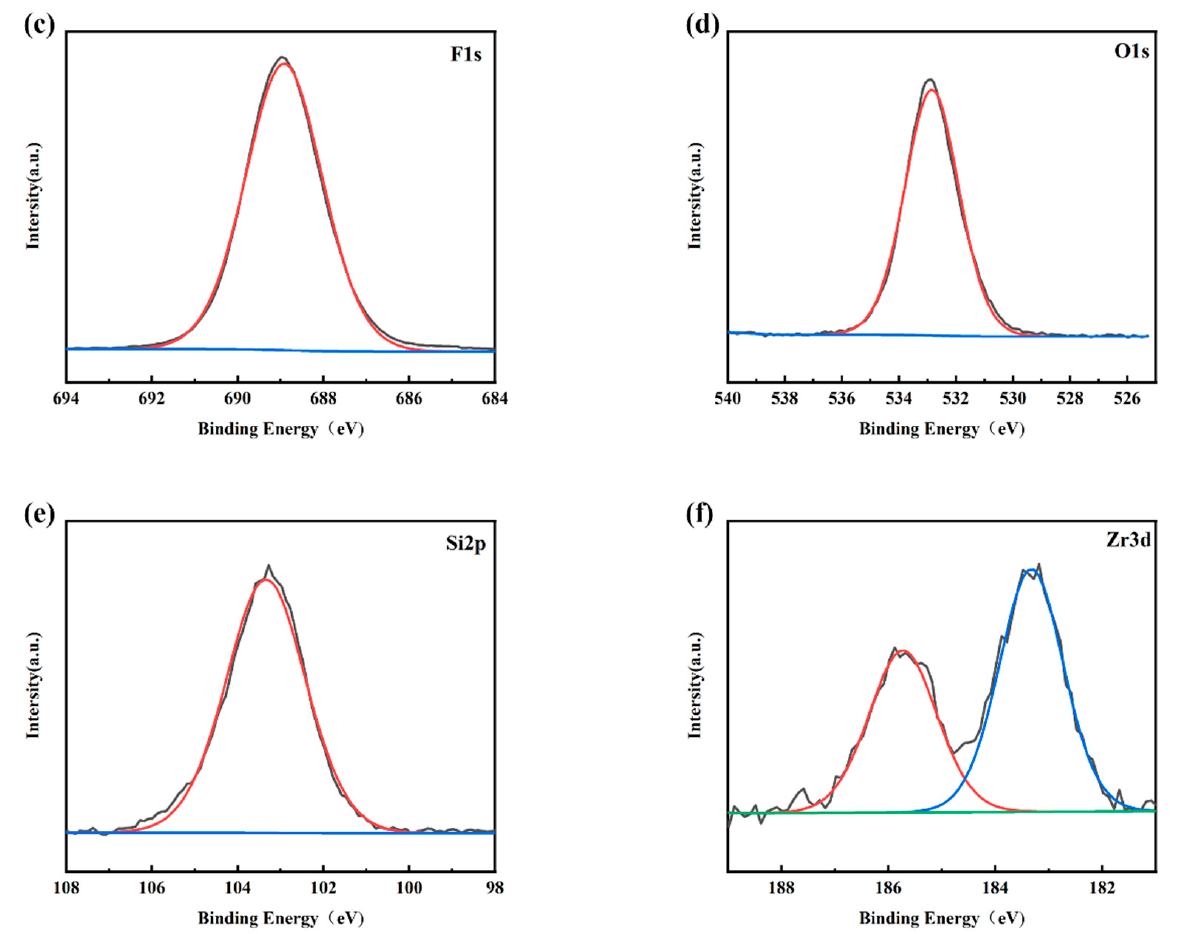
Figure 4. XPS spectra of the PFTS-modified 0.5 g ZrO 2 -SiO 2 sample. ( a ) XPS survey; ( b ) C1s; ( c ) F1s; ( d ) O1s; ( e ) Si2p; ( f ) Zr3d.